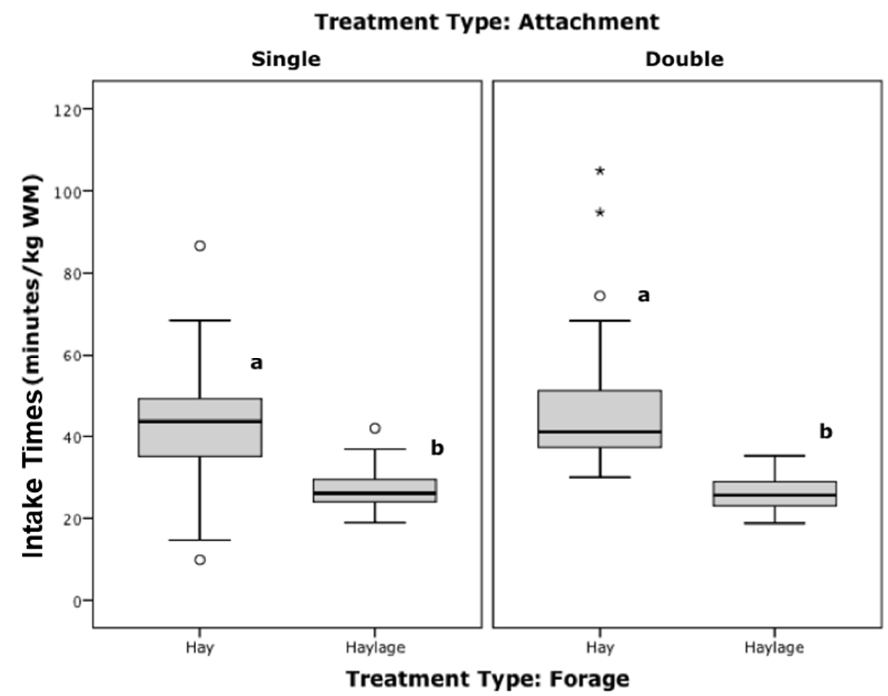
Figure 8. Distribution of intake times, grouped by attachment and forage type. Boxplots that do not share superscripts across all treatments are significantly different ( p < 0.001, Anova, Bonferroni; WM = wet matter/as fed; *, o = outliers).